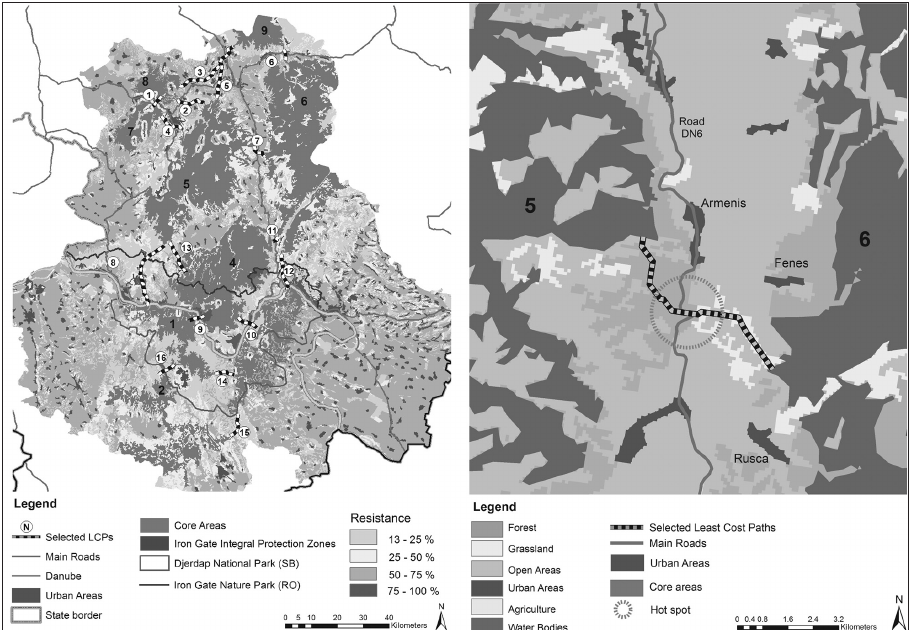
Figure 4–5. 4 Least Cost Paths for Lynx in the PA Djerdap/Iron Gate 5 Closer view of the LCP 7 and the supposed